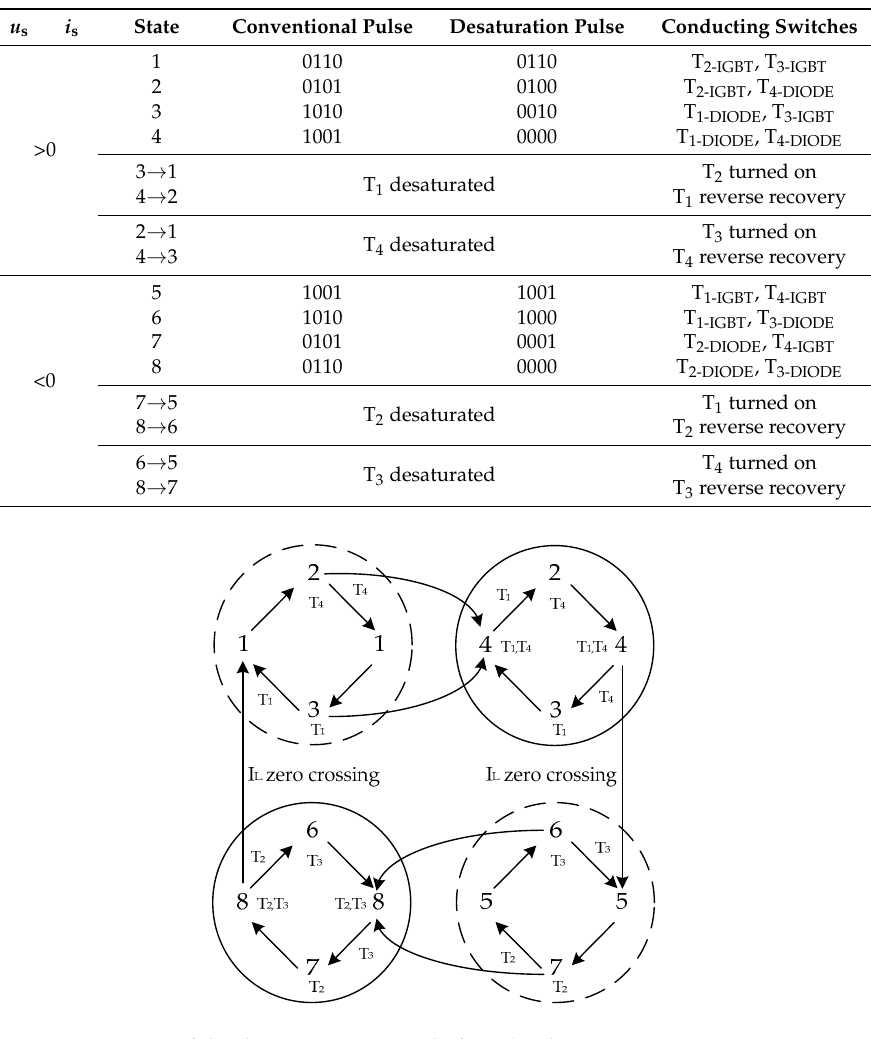
Table 1. Timing of desaturation pulse for RC-IGBT in different working states.